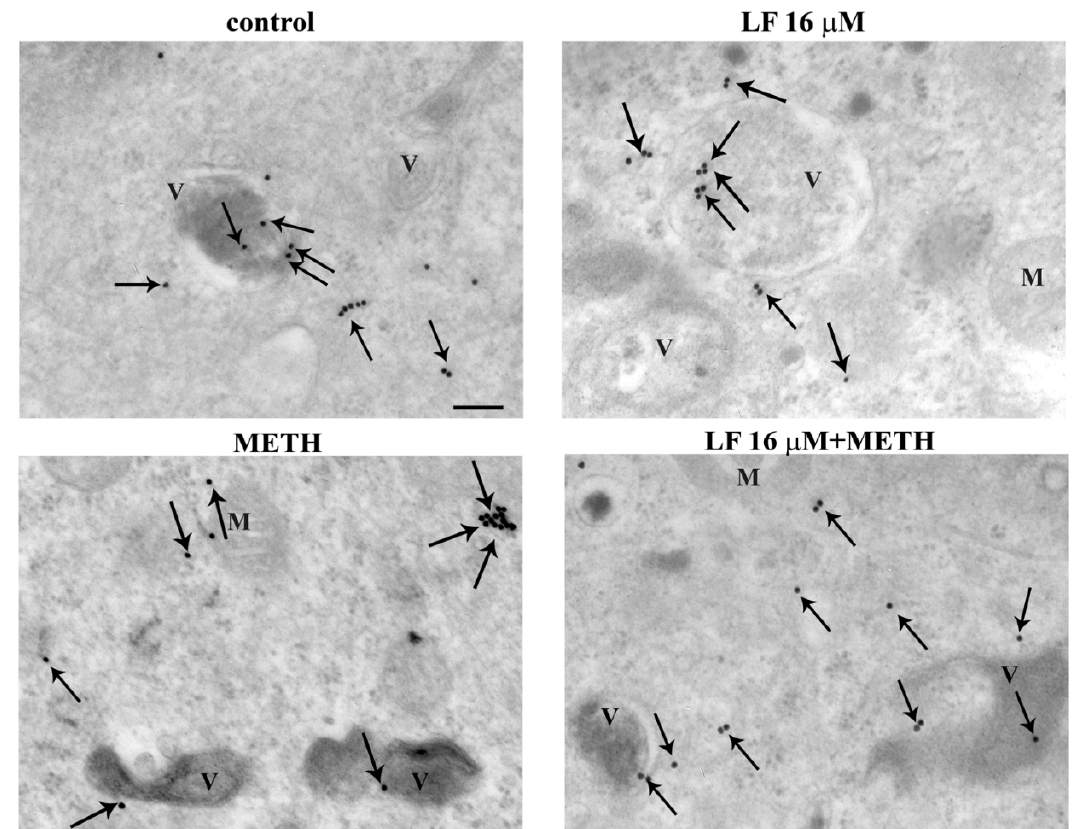
Figure 11. LF increases LC3 compartmentalization within vacuoles. Representative TEM pictures of LC3 positive vacuoles from a control cell and cells treated with either LF 16 µ M or METH or LF + METH. Arrows point to LC3 immuno-gold particles. V = vacuoles; M = mitochondria. Scale bar = 125 nm.